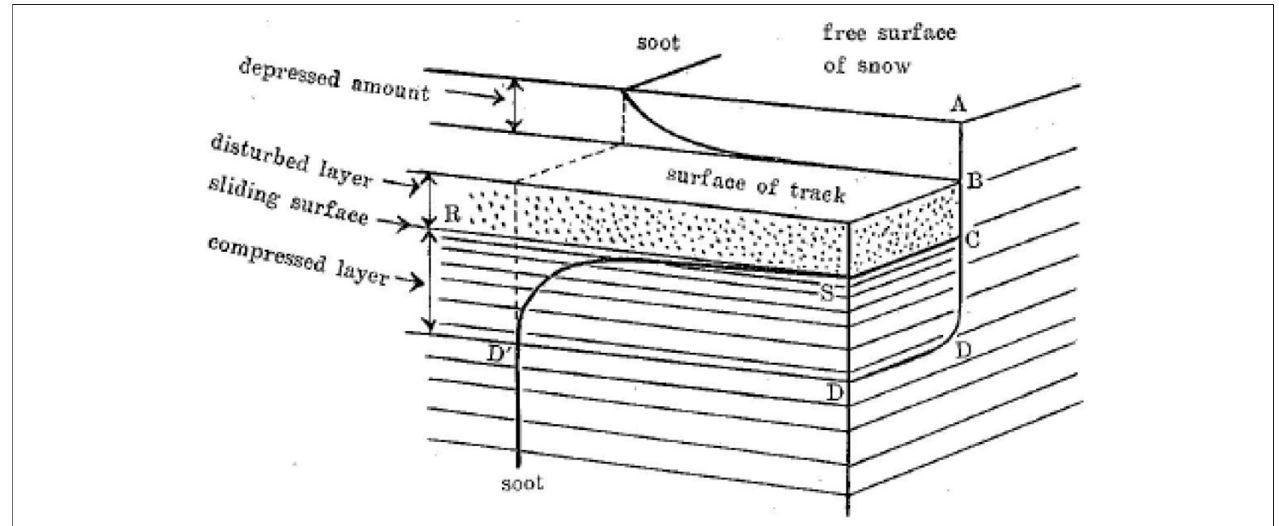
FIGURE2| Schematicofsnowdeformationafterpassagebyaskiorsledonnaturalsnow(reproducedfromNakayaetal.,1936,withthepermissionsofHokkaido University Collection of Scholarly and Academic Papers). A plane of soot placed across the path revealed the subsurface compression (Points A-D) and concurrent shearing (Points D ’ -S) of the snow beneath the slidling plane R-S-C. The slider also fractured and lofted some snow crystals to form disturbed layer R on top of the sliding plane.